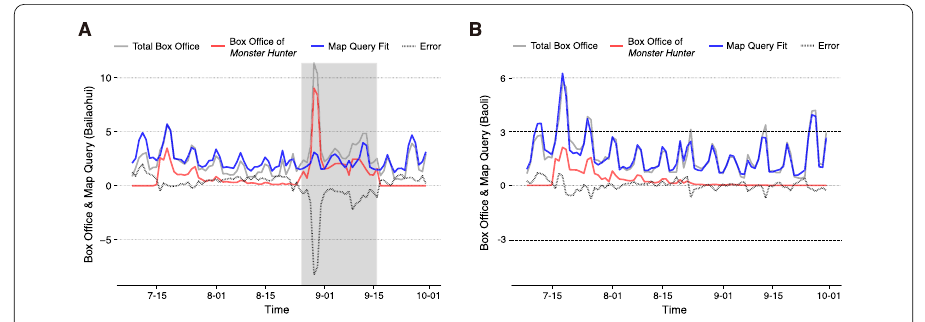
Figure 9 Box office fraud detection. We selected 30 POI of suspected cinemas (A) and another 30 cinema POI as a control group (B) . The forecasting error for the control group was small and stable, whereas for the suspected cinema set, there was a sharp increase in the forecasting error from August 25 to September 16 (marked by the grey box). Such an anomaly indicates a high probability of box office fraud.